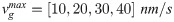
Effect of gel cross-linking velocity on membrane protrusion.(a) The dynamics of membrane’s middle point versus time for different values of vgmax=[10,20,30,40]nm/s. In this case the force Fe = 12 pN is applied to the edges, and the filaments polymerization rates is equal to kpmax=52s-1. (b) Maximum elongation of the membrane versus vgmax at various values of Fe.